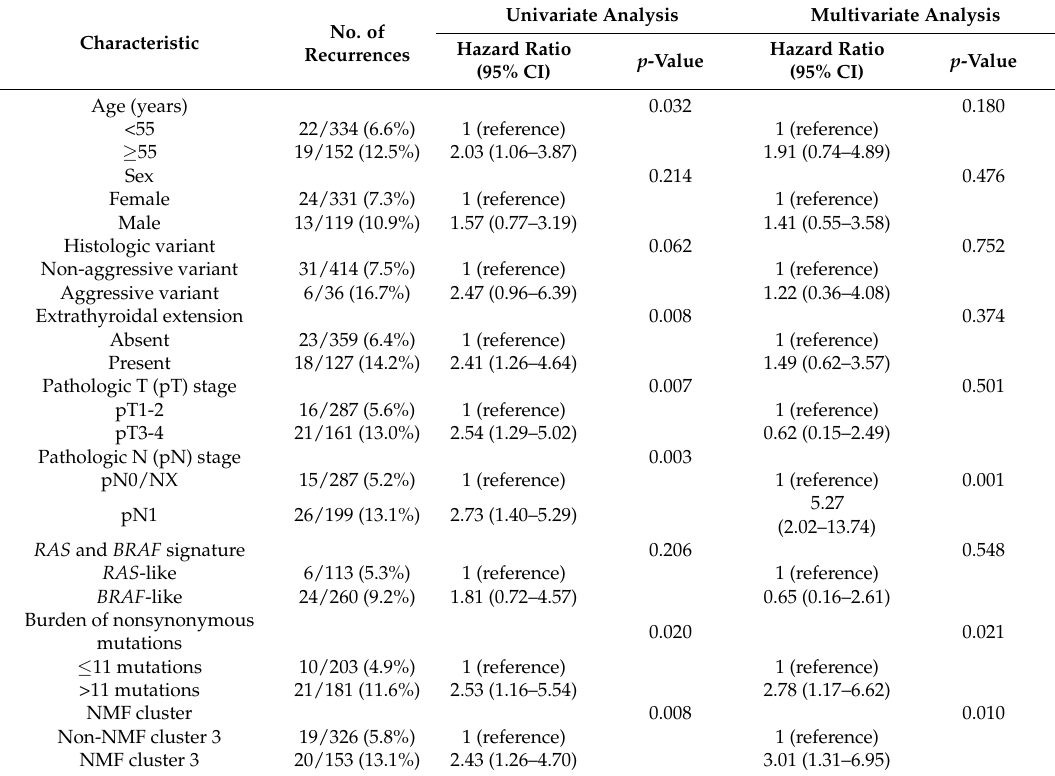
Table 2. Univariate and multivariate logistic regression analyses for risk factors of disease recurrence in the papillary thyroid carcinoma TCGA dataset. Variables showing a tendency of association with recurrence ( p < 0.25) in the univariate analysis were included in the multivariate model. CI: confidence interval.